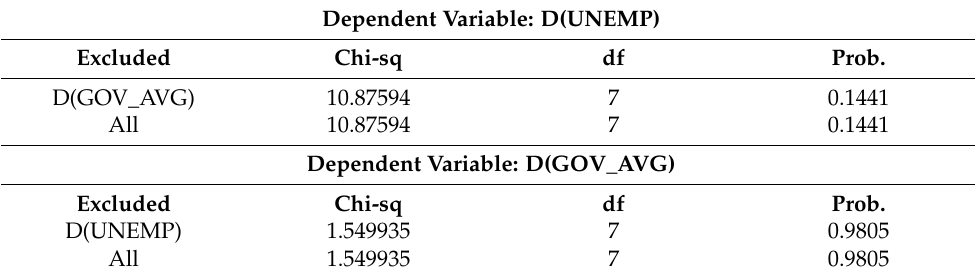
Table 8. Granger causality test